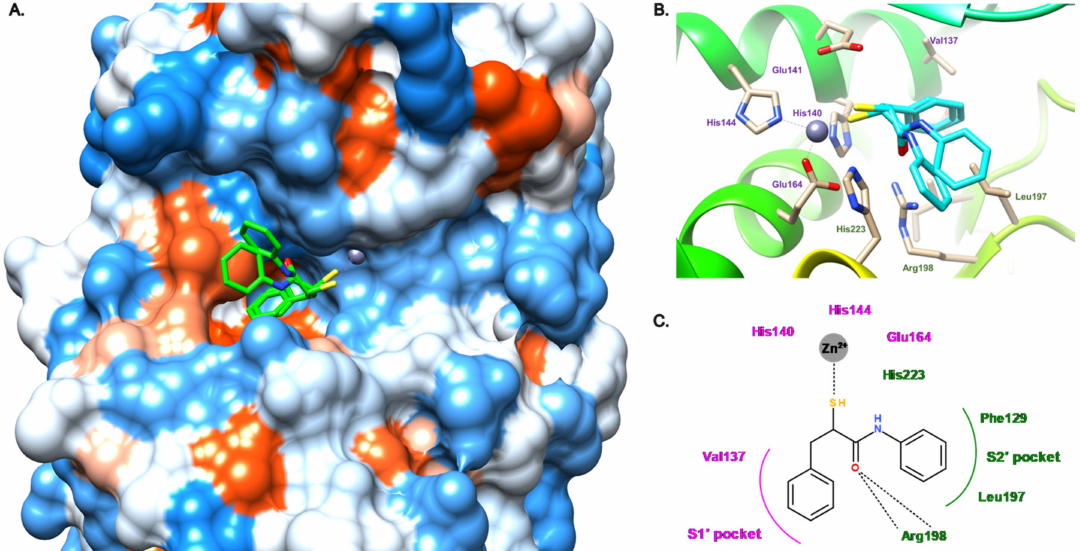
Figure 8. Binding mode of the dehalogenated analogue of 12 from PDB entry 7OC7 [31]. ( A ) View of the active site of LasB, in surface mode, accommodating the dehalogenated analogue of 12 (green, two conformations) visualized using Chimera 1.15. The zinc cation is represented as a gray sphere. ( B ) View of the active site of LasB with the dehalogenated analogue of 12 (blue) and key residues (gray sticks) involved in the binding visualized using Chimera 1.15. ( C ) Two-dimensional schematic representation of the binding mode of the dehalogenated analog of 12 . The key interactions are indicated as dashes, the zinc cation is represented as a gray sphere, and the key residues are indicated in pink for those belonging to the S1 (cid:48) pocket and green for those belonging to the S2 (cid:48)